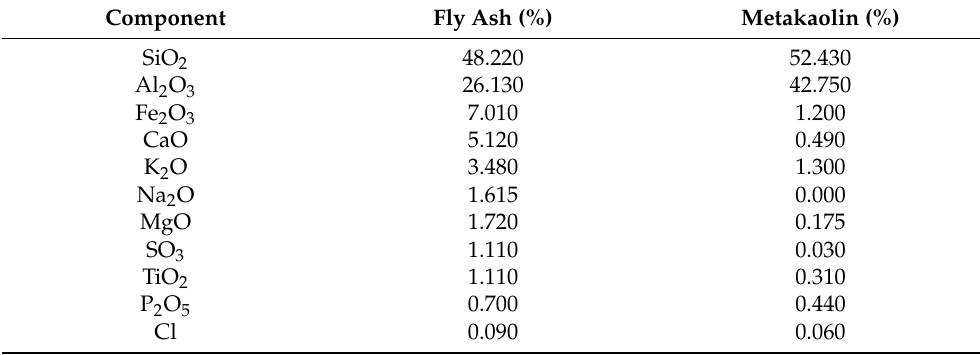
Table 1. The chemical composition of the fly ash and metakaolin determined by X-ray fluorescence analysis, wt%